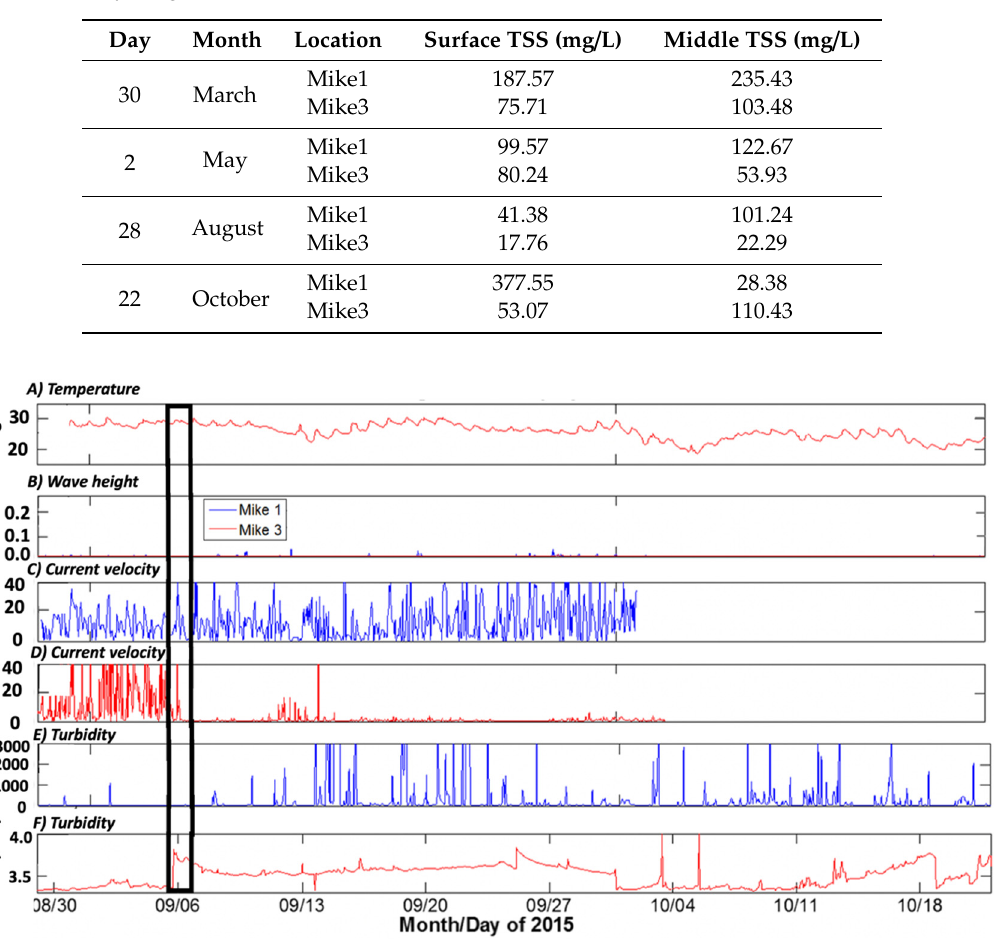
Figure 6. Water temperature, wave height, current velocity, and turbidity data, measured in nephelometric turbidity unit-NTU, during the instrument deployment in Mike Island (Wax Lake Delta, LA, USA) in September / October 2015; ( A ) temperature, ( B ) wave height, ( C ) current velocity (Mike1), ( D ) current velocity (Mike3), ( E ) turbidity (Mike1), ( F ) turbidity (Mike3); note the sharp water velocity reduction and increase in turbidity at Mike3 on 6 September 2015 (rectangle inset).